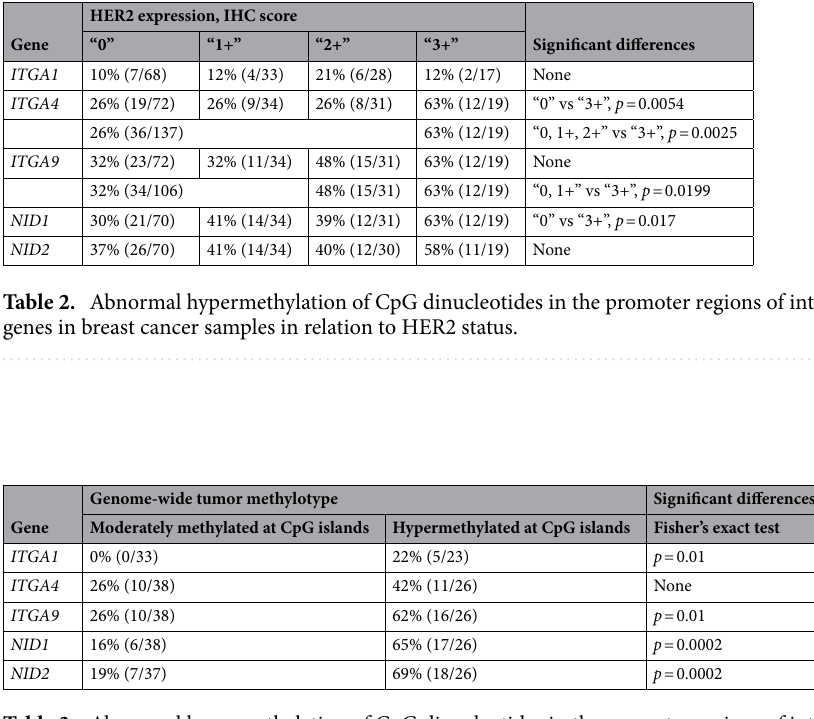
Table 3. Abnormal hypermethylation of CpG dinucleotides in the promoter regions of integrin and nidogen genes in breast cancer samples in relation to genome-wide tumor methylotype.